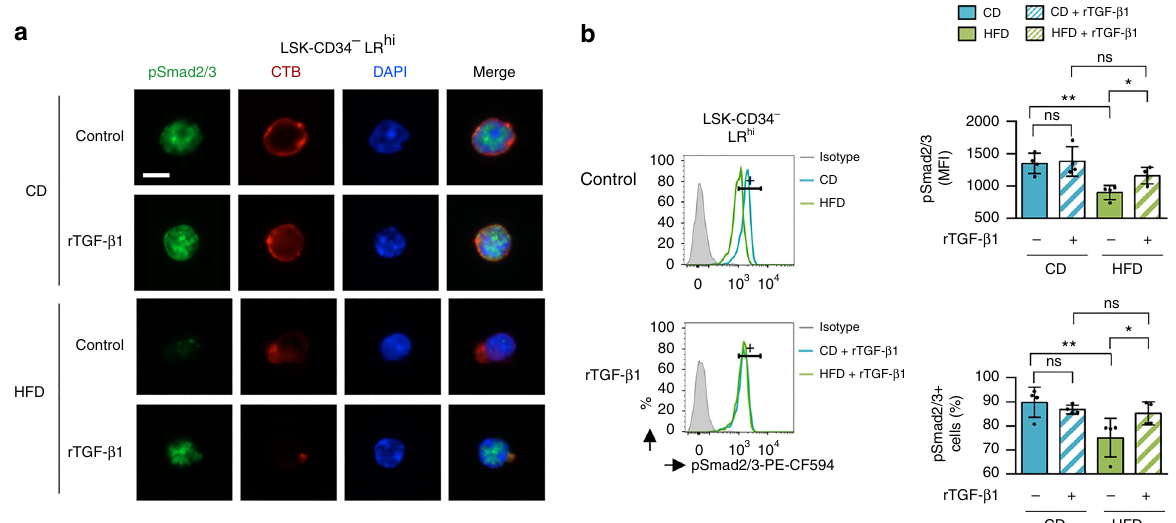
Fig. 9 rTGF- β 1 attenuates HFD-mediated inactivation of pSmad2/3 in LSK-CD34 − LR hi HSC. a Single-cell immunostaining is performed on LSK-CD34 − LR hi HSC isolated by FACS and using an anti-pSmad2/3 (green), CTB (red), and DAPI (blue). Data show examples of representative single-cell immunostaining for CD and HFD-fed mice, treated or not by recombinant TGF- β 1 (rTGF- β 1 injected in vivo at 1.3 µ g/kg) twice per week during the 4 weeks of the diet, n = 2 mice per experimental group. White scale bar represents 5 µ m. b The pSmad2/3 signal in LSK-CD34 − LR hi HSC from CD and HFD-fed mice, treated or not by recombinant TGF- β 1 (rTGF- β 1 injected in vivo at 1.3 µ g/kg) twice per week during the 4 weeks of the diet, is detected by fl ow cytometry. Results show their expression (MFI; median fl uorescence intensity) and proportion (%) of pSmad2/3 + cells among LSK-CD34 − LR hi HSC, n = 4 mice per experimental group. Data show mean ± SD; ns, non-signi fi cant ( P > 0.05); ** P < 0.01 (two-tailed unpaired Student ’ s t -test)